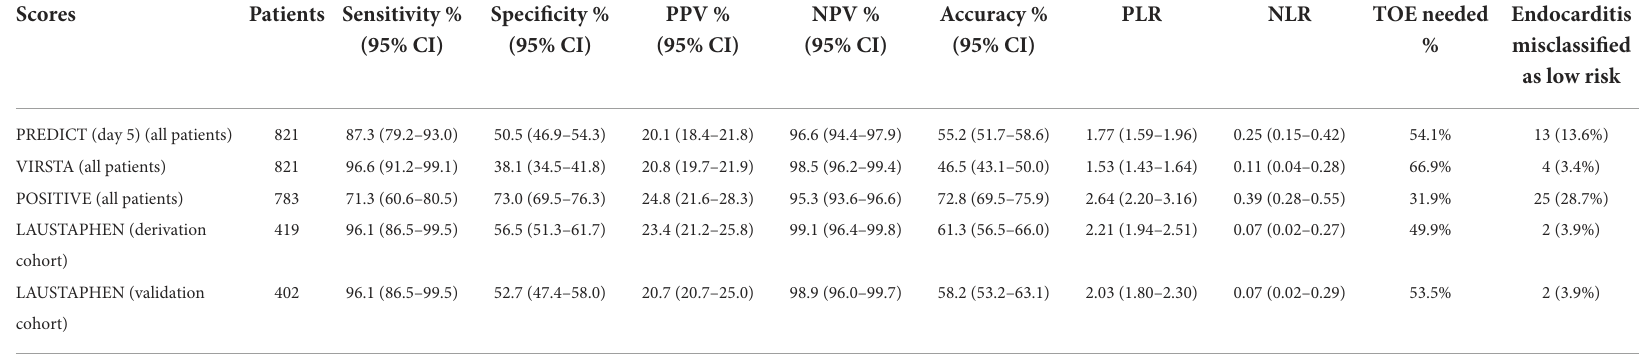
TABLE 4 Diagnostic accuracies of the fifth day PREDICT, VIRSTA, POSITIVE, and LAUSTAPHEN in predicting cardiac lesions (according to imaging and pathological 2015 ESC-modified Duke